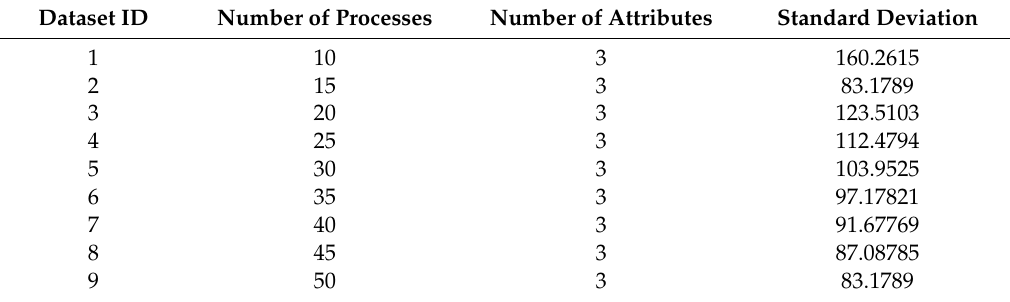
Table 7. Datasets specifications. The first column presents the dataset ID, the second column presents the number of processes in each dataset, the third column presents the number of attributes (i.e., BT, PW, and NCS), and the forth column presents the standard